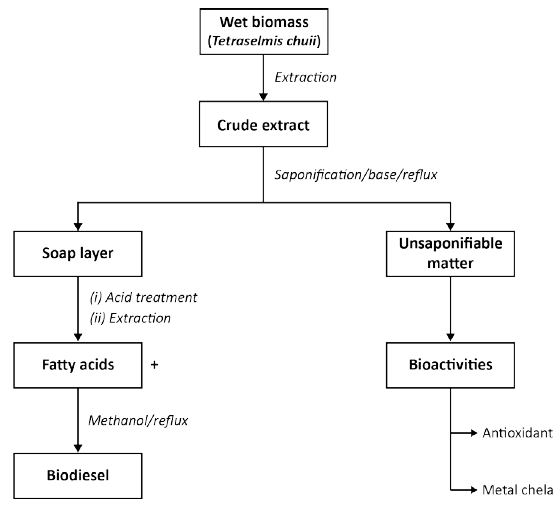
Figure 1: Schematic diagram of biodiesel production and evaluation bioactivities studies of UM from microalgae.